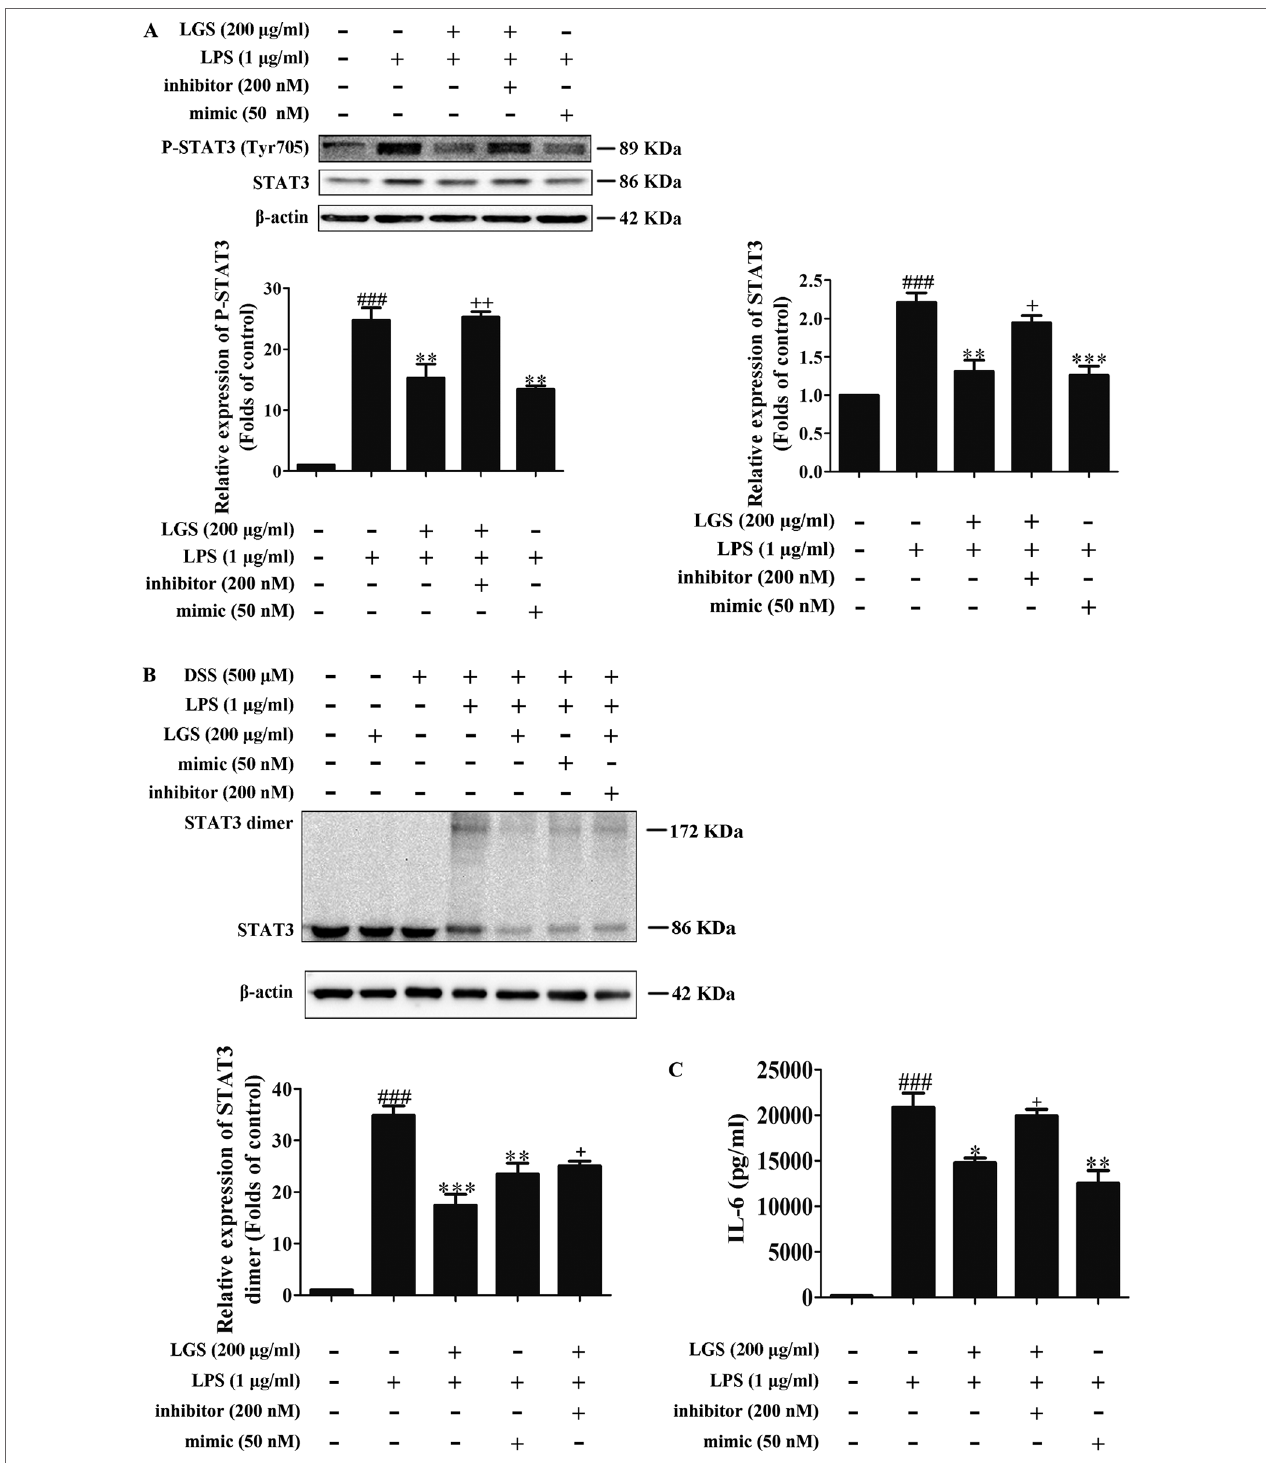
FIGURe 5 | The blockage of miR-21 attenuates inhibitory effects of LGS on the STAT3 signaling pathway. The cells were transfected with miR-21 mimic or inhibitor for 24 h. After transfection, macrophages were incubated with LGS (200 μg/ml) and LPS (1 μg/ml) for another 24 h. (A) The inhibition of miR-21 decreases the inhibitory effects of LGS on the protein expressions of P-STAT3 (Tyr705) and STAT3. The protein expressions were measured by Western blotting. (B) The inhibition of miR-21 attenuates the inhibitory effect of LGS on STAT3 dimer. DSS was used to cross-link the protein and Western blotting was used to measure the dimer content of STAT3. (C) The inhibition of miR-21 increases the level of IL-6. The generation of IL-6 was detected by ELISA. Data are represented as the mean ± SEM of three independent experiments. ### P < 0.001 versus control, * P < 0.05, ** P < 0.01 and *** P < 0.001 versus LPS treatment, + P < 0.05, ++ P < 0.01 versus LGS treatment by one-way ANOVA with Tukey’s test.